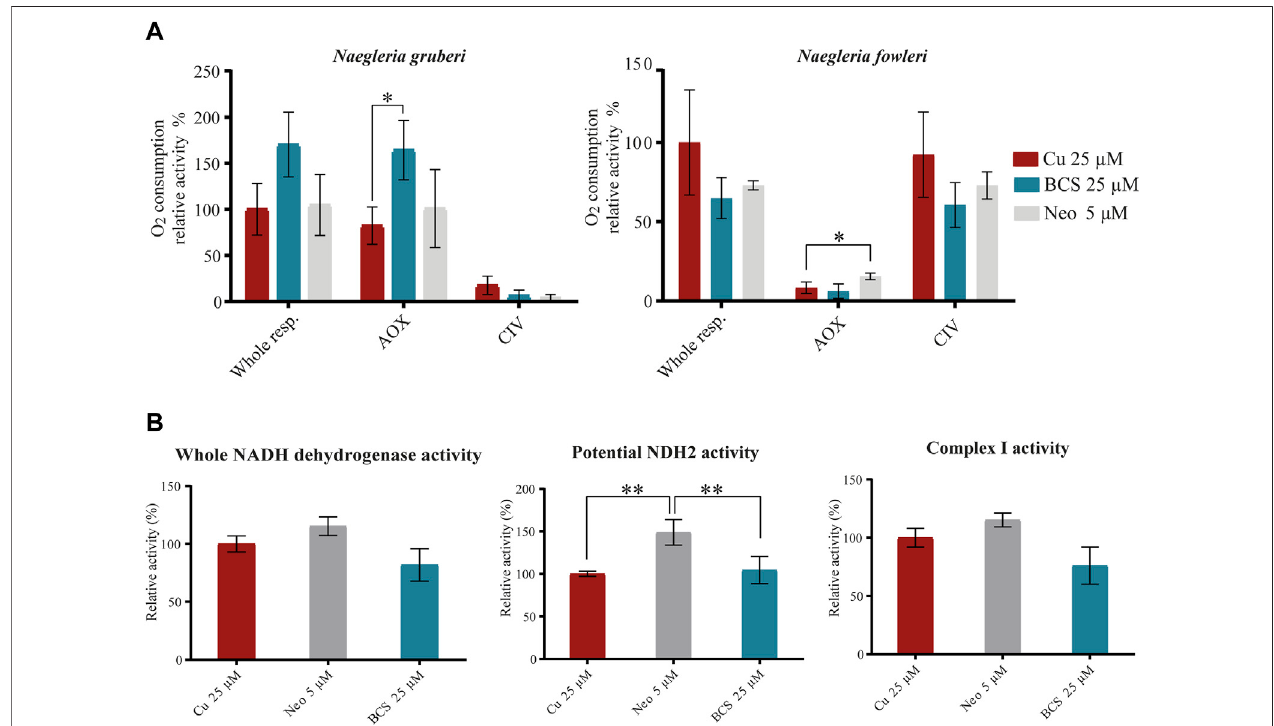
FIGURE3| TheactivityofNgAOXand NfNDH2re fl ectstheproteomicanalysisresults. (A) OxygenconsumptionofNgAOXisincreasedduetocopper deprivation. Oxygenconsumptionwasmeasuredin N.gruberi and N.fowleri cellsincubatedfor72 hwith25 MBCSor5 µMneocuproine,andcontrolcellsweresupplementedwith 25 µMCu 2 SO 4 .Speci fi cinhibitorsofalternativeoxidase(SHAM)andcomplexIV(KCN)wereusedtodistinguishtheactivitiesoftheseenzymes.Foreasierinterpretation, oxygen consumption activity was calculated as the relative activity, where the whole respiration of control samples (Cu 25 µM) corresponds to 100%. The graphs showthemeanofthreebiologicalreplicateswiththestandarddeviation.Toevaluatethestatisticalcon fi dence,Student ’ sttestwasused(*indicatesa p value ≤ 0.05). (B) The enzyme activity of NfNDH2 is increased under low copper conditions. Spectrophotometric measurement of NADH dehydrogenase activity was measured using nonnatural Q2, the analog of Q10, at 340 nm on N. fowleri cells incubated in low or normal copper conditions. The potential NDH2 activity was measured after preincubation of the cells with rotenone. The activity of complex I was calculated by subtracting the potential NDH2 activity from overall NADH dehydrogenase activity. For easier interpretation, the activities are shown as the relative activity (%), and the activities of control cells (Cu 25 µM) correspond to 100%. To evaluate the statistical con fi dence, Student ’ s t test was used (**indicates a p value ≤ 0.01).